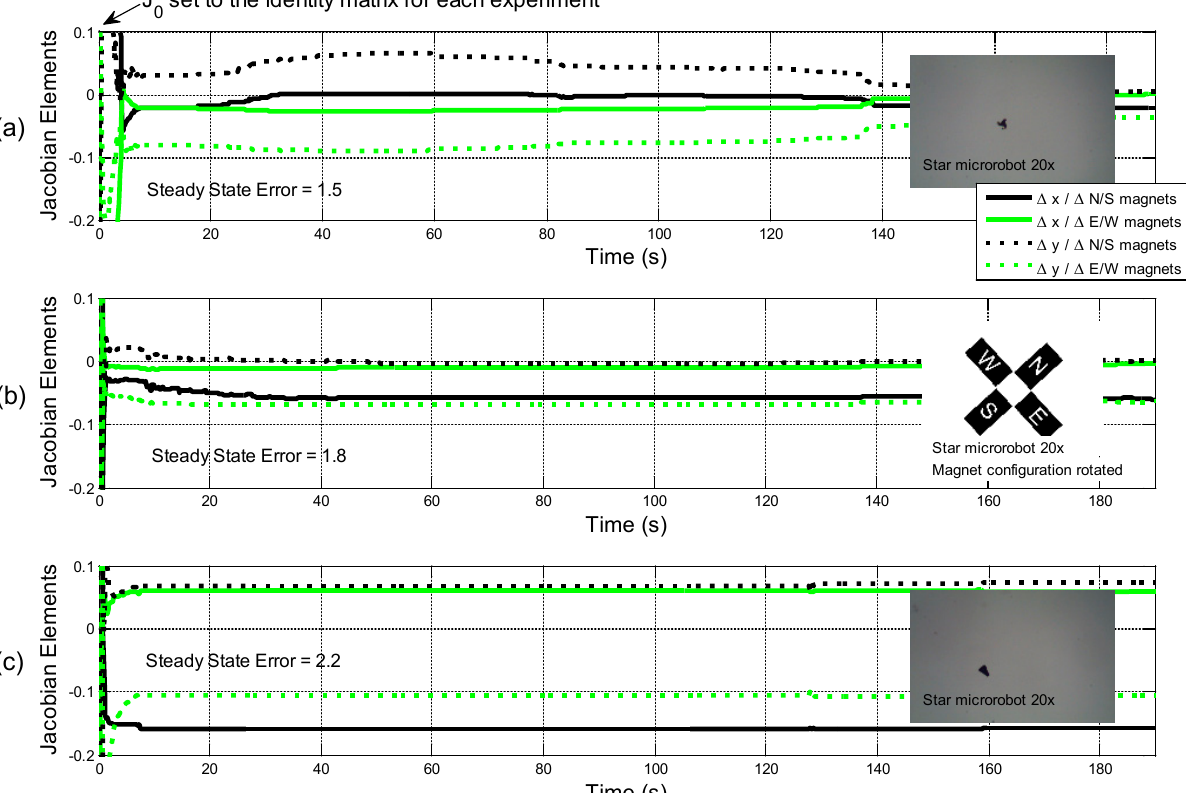
Figure 11. Elements of the Jacobian estimation over time for three experiments: ( a ) a star microrobot with a nominal electromagnet configuration; ( b ) a rotated magnet configuration; and finally, ( c ) a wedge microrobot. In each case, the robot is given a circular path. Low steady state errors indicate effective tracking. Different system configurations result in different Jacobian values necessary for control. Online estimation eliminates the need for a priori calculation of these